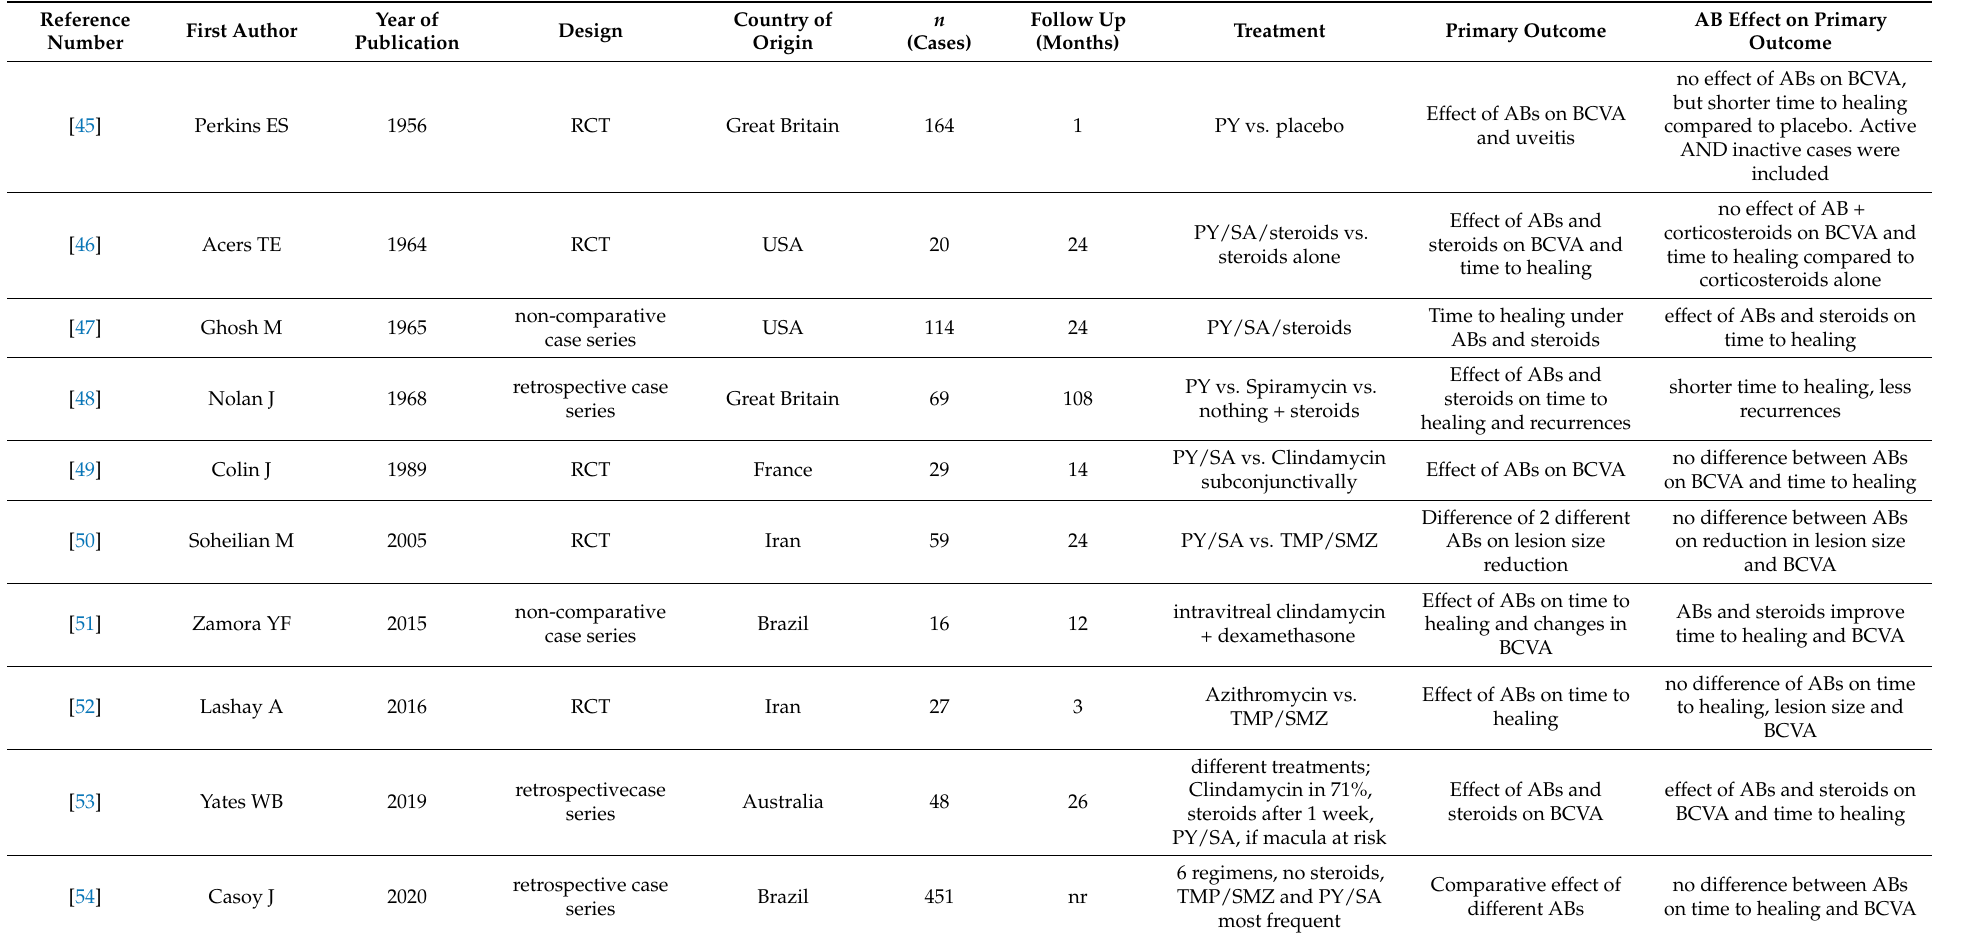
Table 2. Treatment of active OT. Treatment and primary study